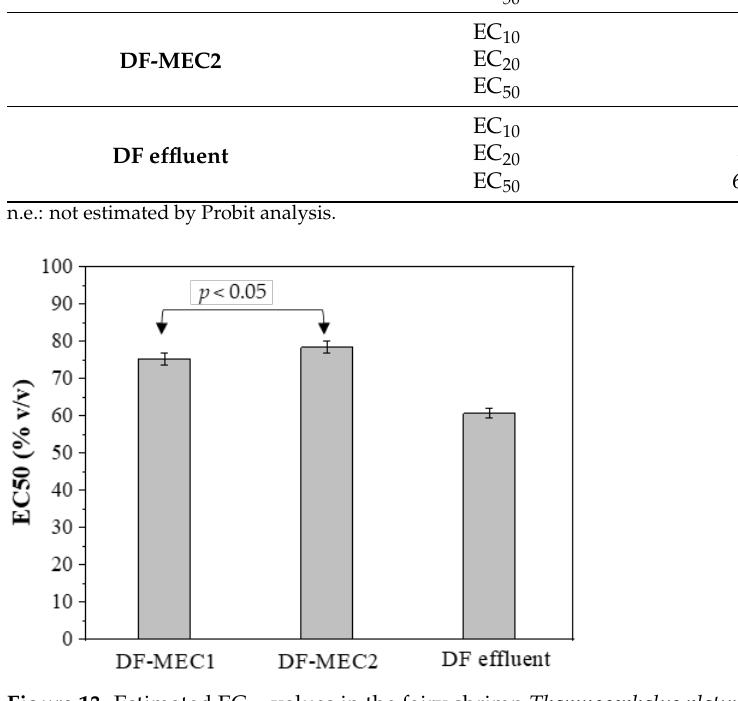
Figure 13. Estimated EC 50 values in the fairy shrimp Thamnocephalus platyurus , after DF (DF effluent samples), as well as DF-MEC1 and DF-MEC2 samples. The results (expressed as % v / v ) are mean ± SD from 3 independent experiments. Values in bracket are statistically different from the respective value obtained in feeding samples (Mann Whitney u-test, p < 0.05, N = 3).